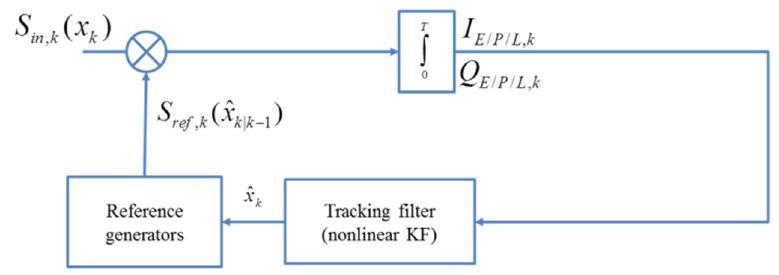
Figure 1. A block diagram of a nonlinear KF-based GPS carrier tracking system.